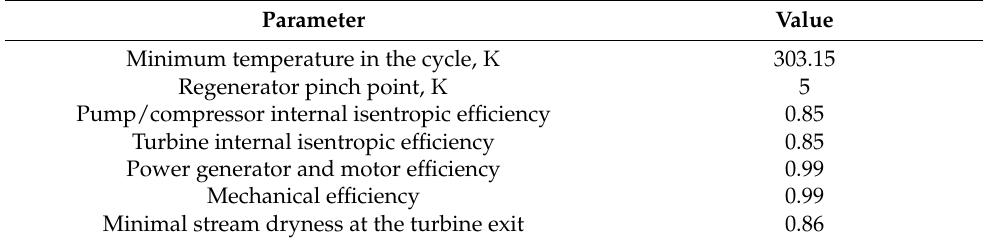
Table 5. Analysis of input data.